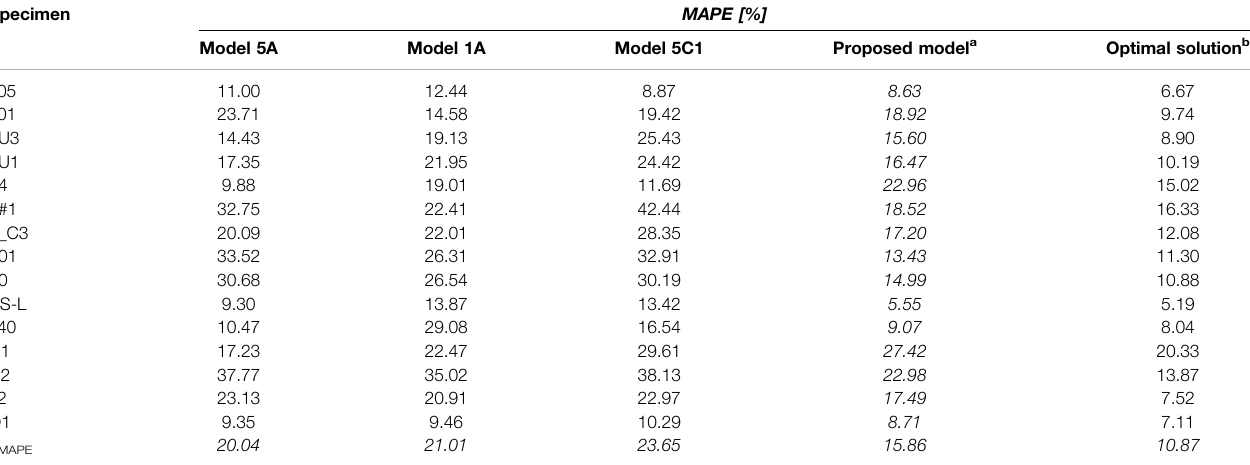
TABLE 8 | Mean absolute percentage errors and their mean values calculated for: a) the best three literature models (5A, 1A and 5C1); b) the proposed model, and c) the optimal solution. Specimen